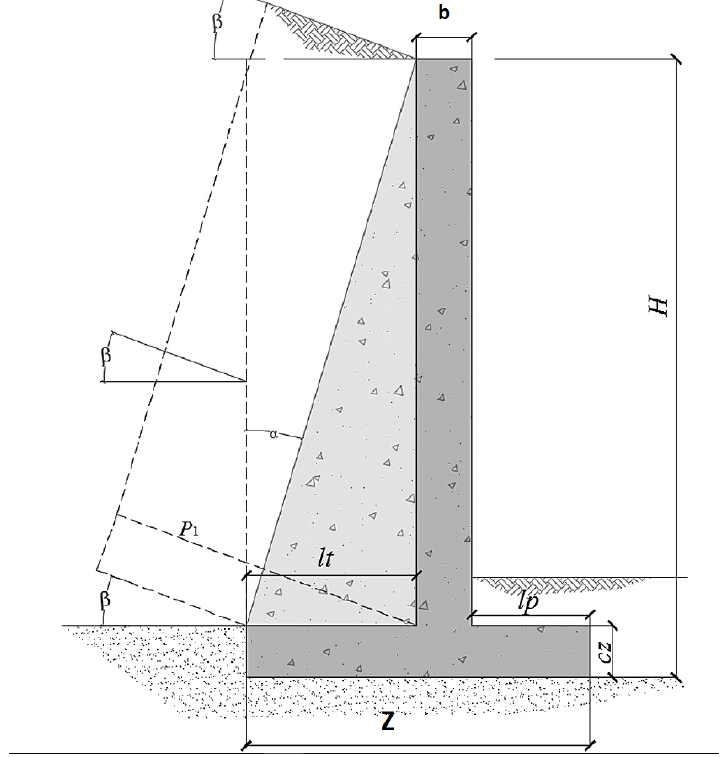
Figure 4. Problem design parameters [58]. Table 2. Design